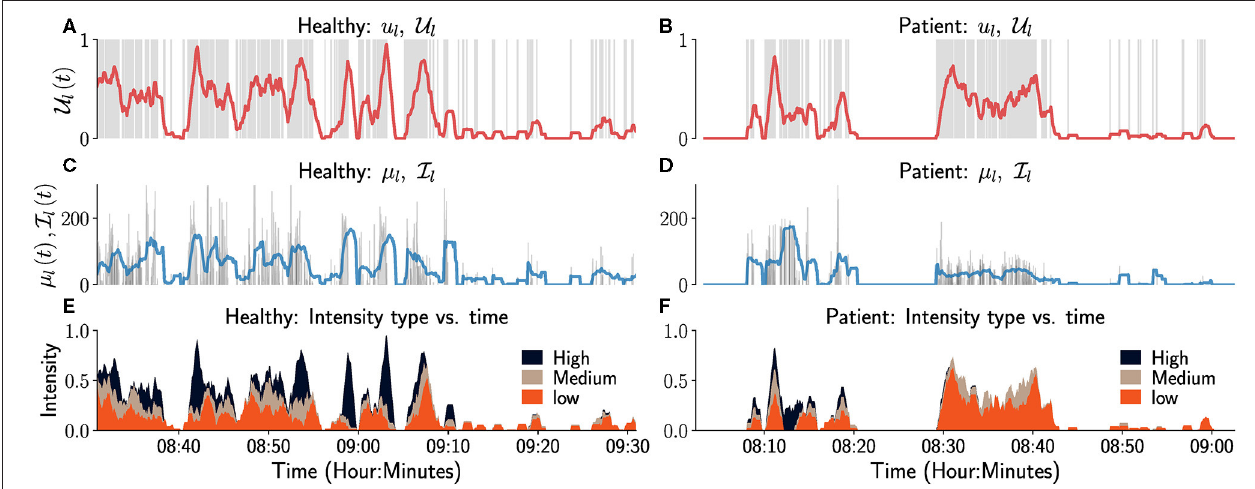
FIGURE 3 | Temporal visualization of constructs related to left upper-limb use and intensity. The left and right columns correspond to data from a healthy participant and a patient, respectively. (A,B) depicts the left upper-limb use signal u l as a gray-colored event plot, where the vertical gray line at time t indicates u l (t) = 1. And the light red colored graph shows the corresponding average upper limb use U l . (C,D) depicts the instantaneous intensity of use µ l (gray) and the average intensity of use I i (light blue) for the left upper-limb. (E,F) depicts the proportion of time the intensity of use was low (orange), medium (brown), or high (black) in the last 60 s. Although not shown in these figure, it would also be useful to indicate in such plots periods of time where there is no data available, i.e., periods where a wearable sensor has been removed and is not recording movement data from a